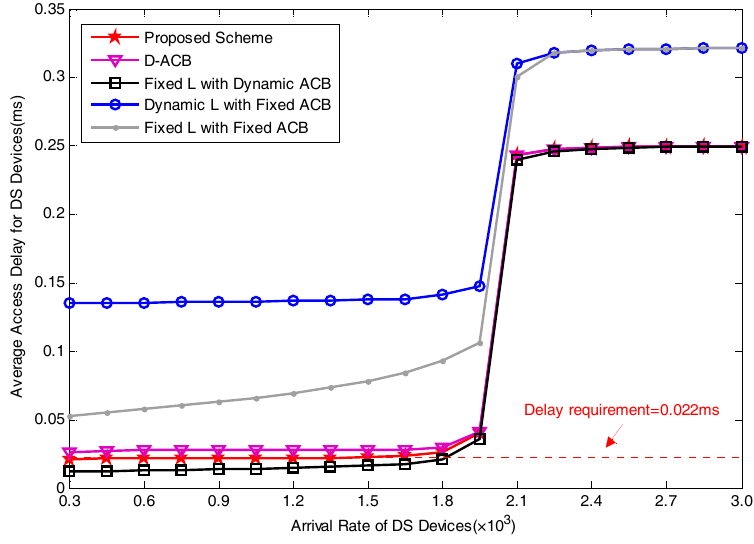
Figure 9. Average Access Delay for varying arrival rates.